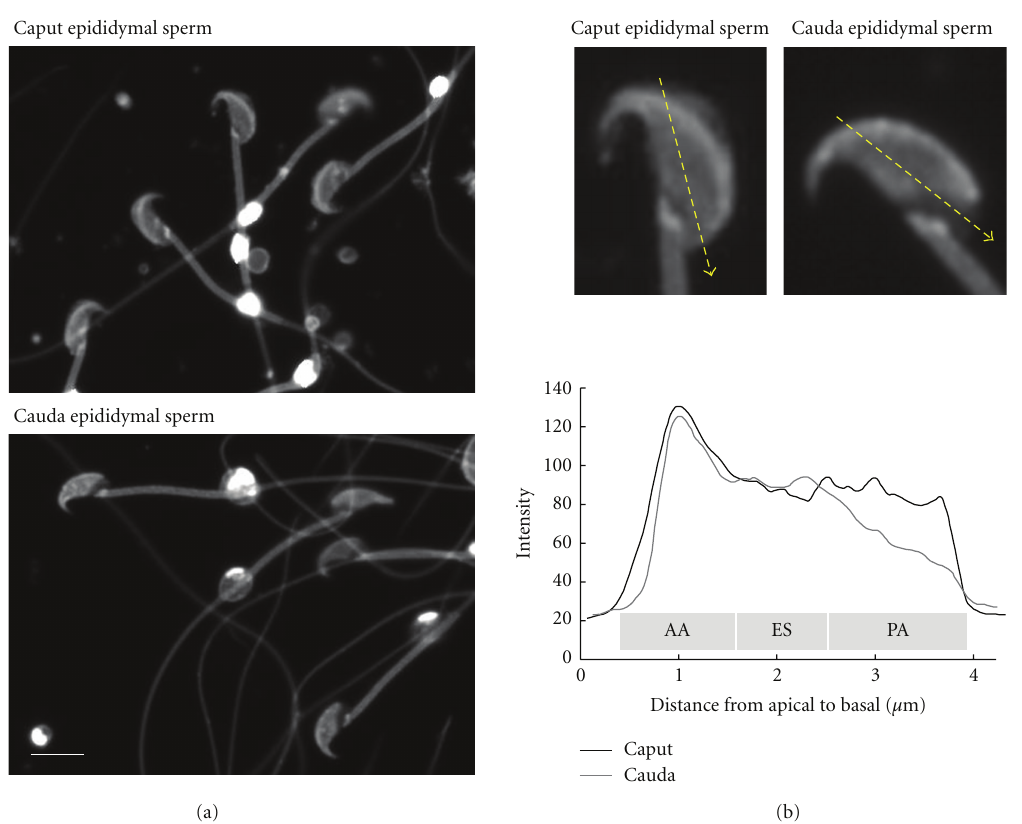
Figure 2: Distribution of cholesterol during sperm maturation in murine epididymis. (a) Sperm collected from caput epididymis reveal filipin signal on the whole head. After epididymal transit (cauda epididymis), the signal is not detected in the postacrosomal region (PA). Scale bar = 5 μ m. (b) Densitometric analysis shows a significant decrease of filipin signal at the postacrosomal region. AA, apical acrosome; ES, equatorial segment; PA,